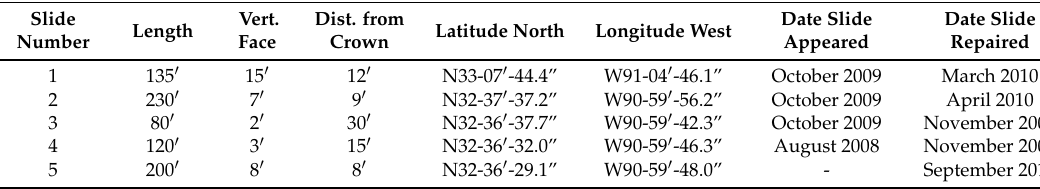
Table 1. Ground truth data from the Mississippi Levee Board.